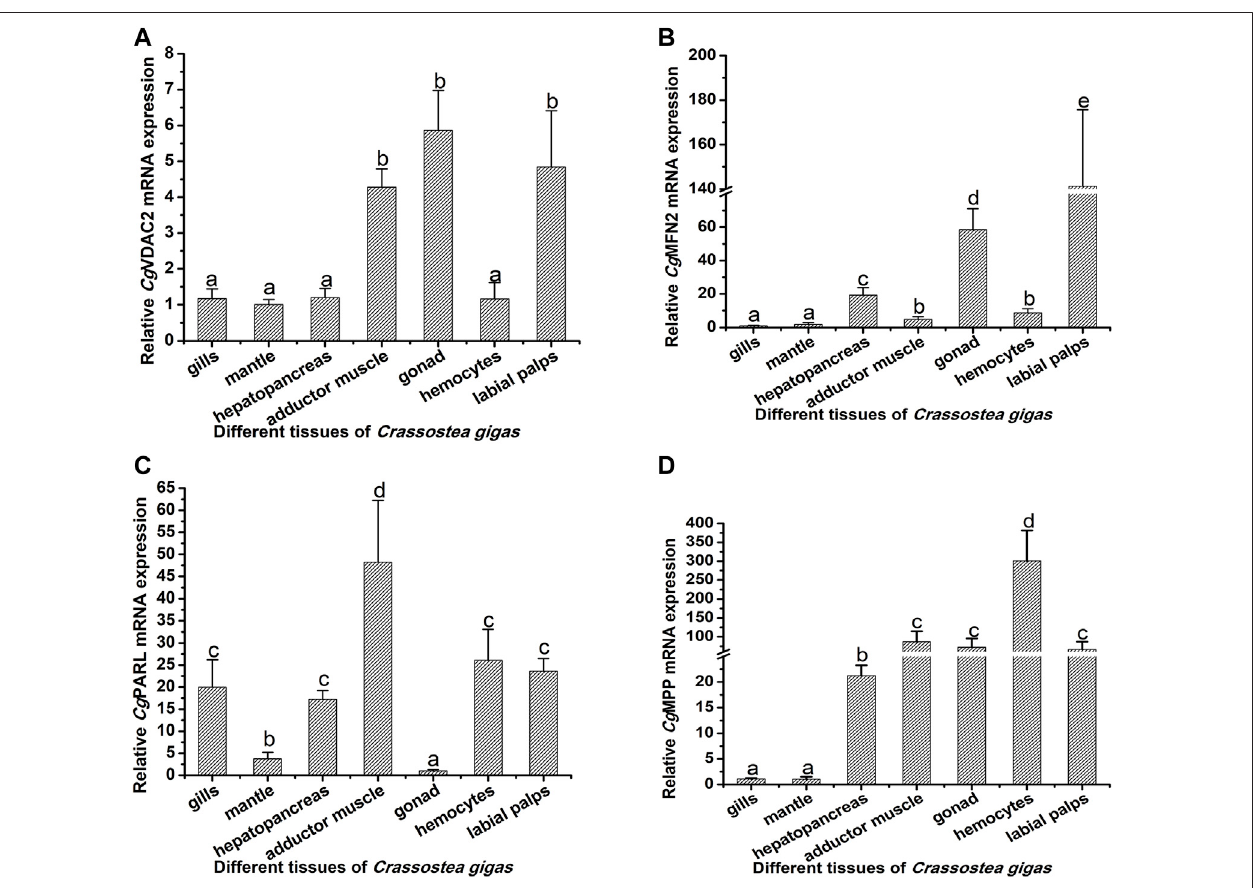
FIGURE 4 | Tissue distribution of Cg VDAC2, Cg MFN2, Cg PARL, and Cg MPP. The relative mRNA expression levels of Cg VDAC2 (A) , Cg MFN2 (B) , Cg PARL (C) , and Cg MPP (D) indifferenttissueswerenormalizedtothatofgills.EFwasusedastheinternalcontrol.Theverticalbarsareshownasmean±S.D.(N=3).Differentletters indicate signi fi cant differences between groups ( p < 0.05, one-way